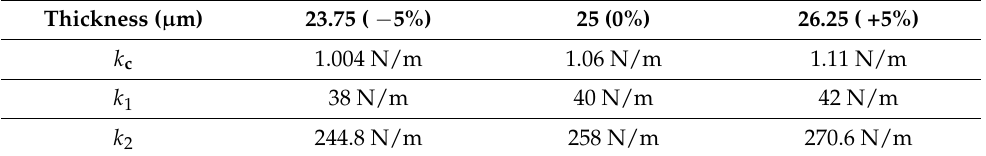
Table 3. Three different levels of mechanical springs with respect to ± 5% variation in beam thickness.